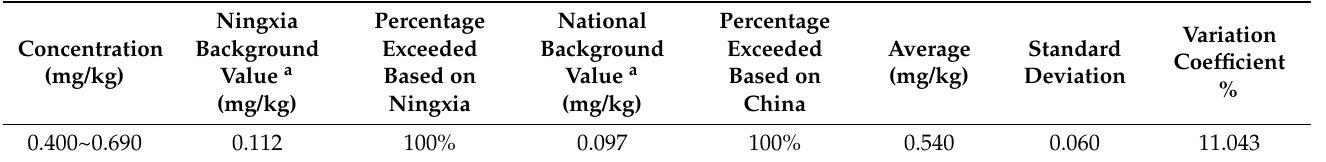
Table 5. Measurement and statistics of soil sample Cd content.